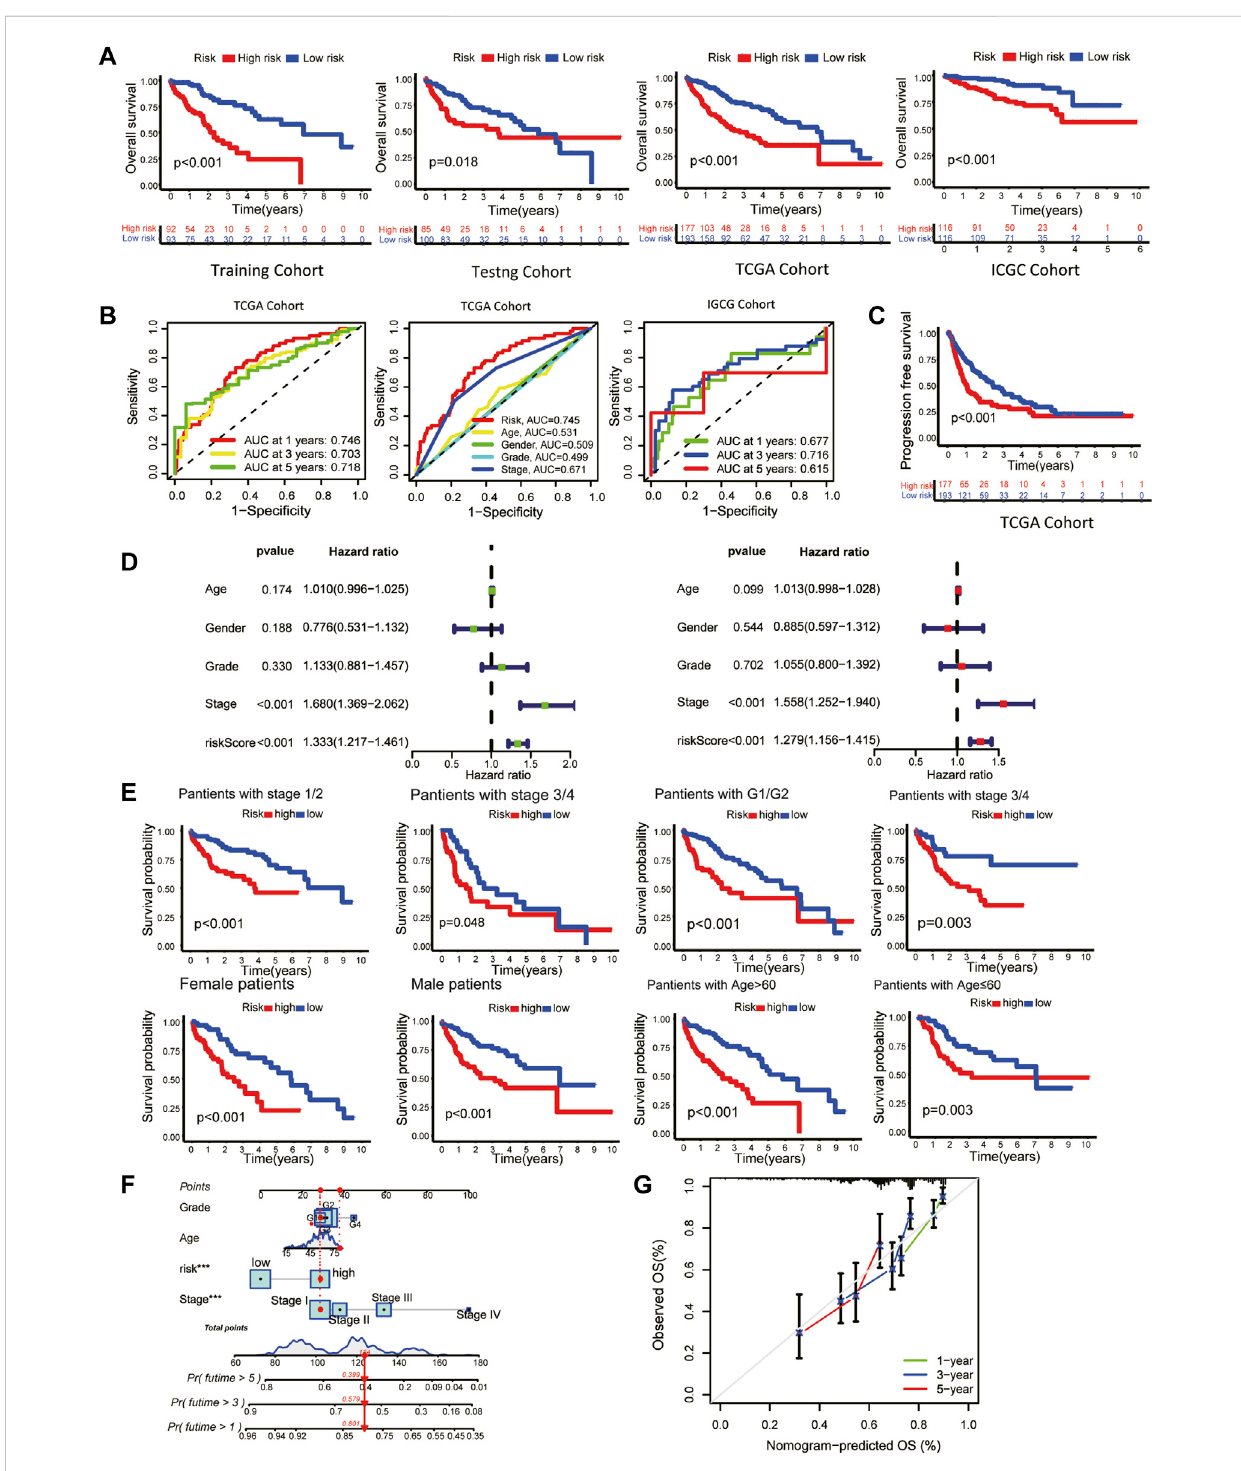
FIGURE 2 Clinical validation of the prognostic signature. (A) The Kaplan-Meier overall survival (OS) curves of the risk score in the training, testing, TCGA, and ICGC cohorts. (B) Receiver operating characteristic (ROC) curve based on the risk score and other clinicopathological features for predicting OS in HCC patients. (C) Kaplan-Meier Progression – free Survival (PFS) curve. (D) Univariate (left) and multivariate (right) Cox regression analyses. (E) Kaplan-Meier survival subgroup analysis strati fi ed by clinical characteristics. Grouping criteria: age > 60/ ≤ 60, gender, histological grade, TNM stage. (F) OS nomogram (G) Nomogram calibration for the OS